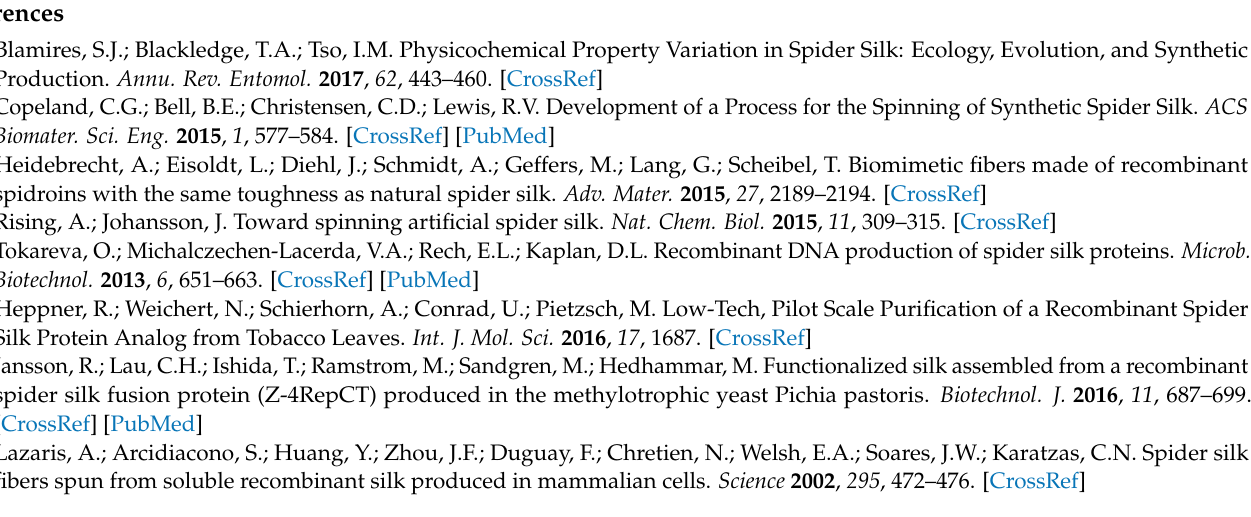
S2: LC-UV detection of pigments, Figure S3: MS/MS spectra of C10H6N2O6 compound, Figure S4: Quantitation of xanthurenic acid by reduction of Fe3+ - TPTZ